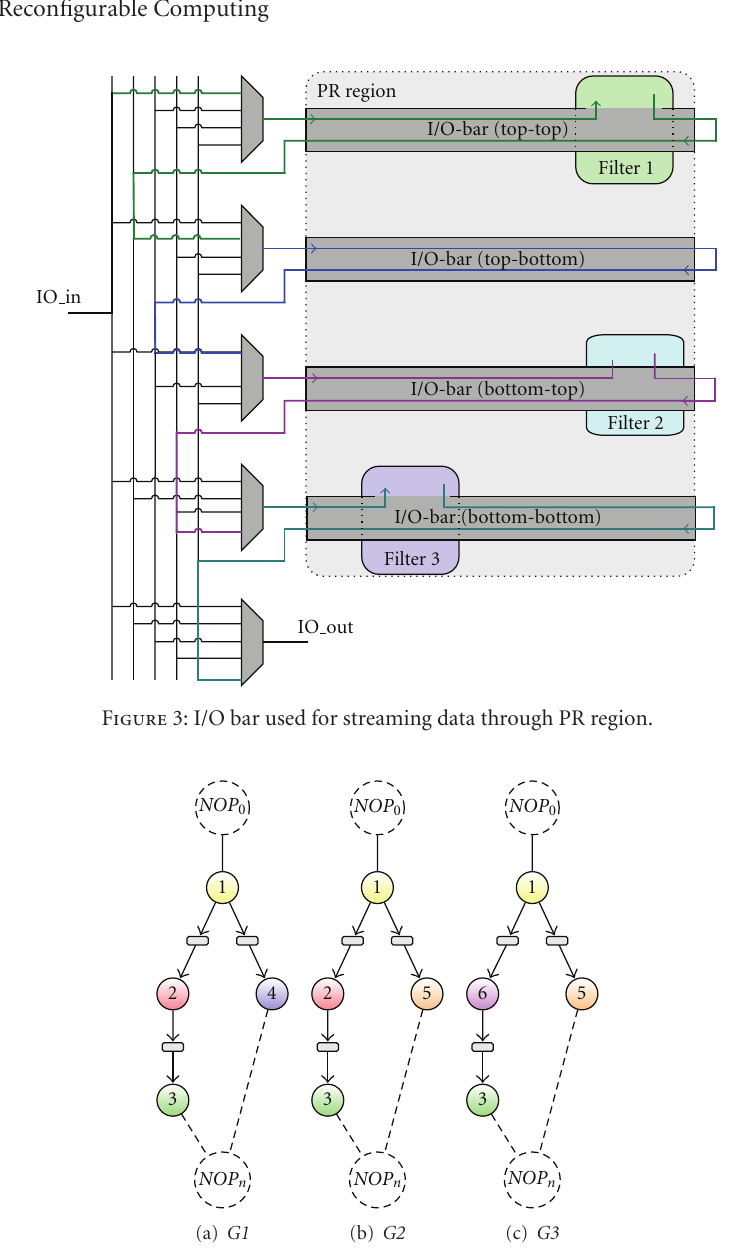
Figure 4: Example of data flow graphs with strong similarities that can be